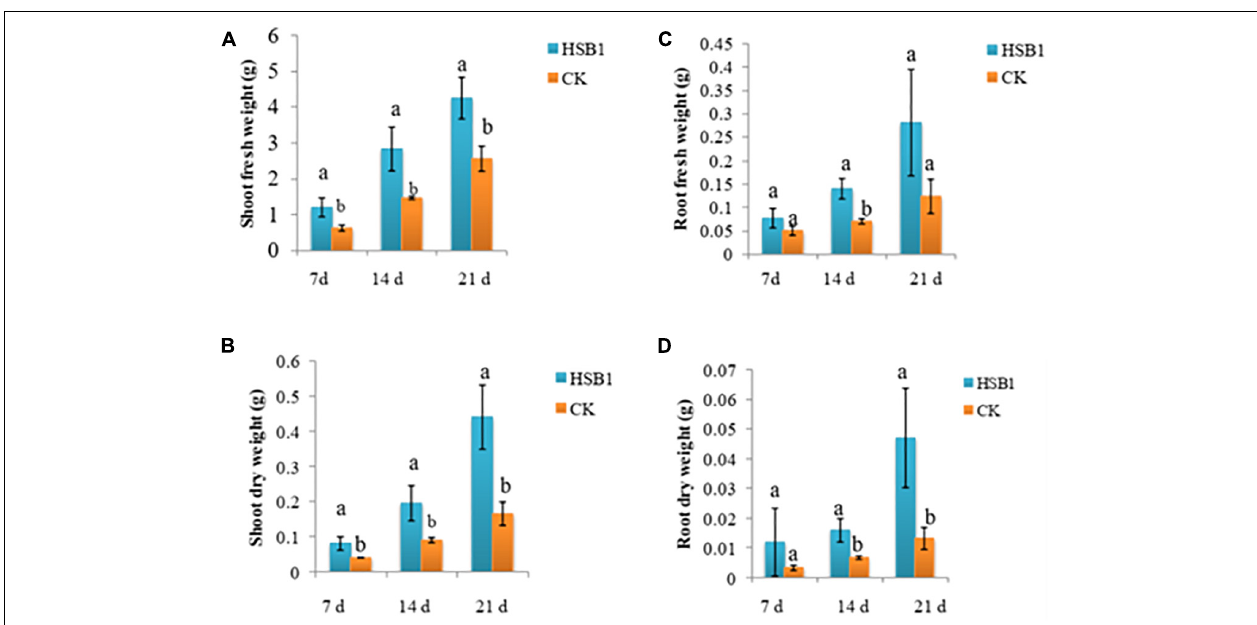
FIGURE 4 | Bar graphs showing changes in shoot weight (A,B) , and root weight (C,D) of wolfberry seedlings whose soil was treated with Bacillus amyloliquefaciens strains (FZB42 or HSB1) compared to a water control (CK). Measurement time points are based on days after inoculation growth at 7, 14, and 21 days after inoculation. Error bars represent standard deviation of three replicates. Letters above each bar indicate significant differences from the control (CK) ( p < 0.05).